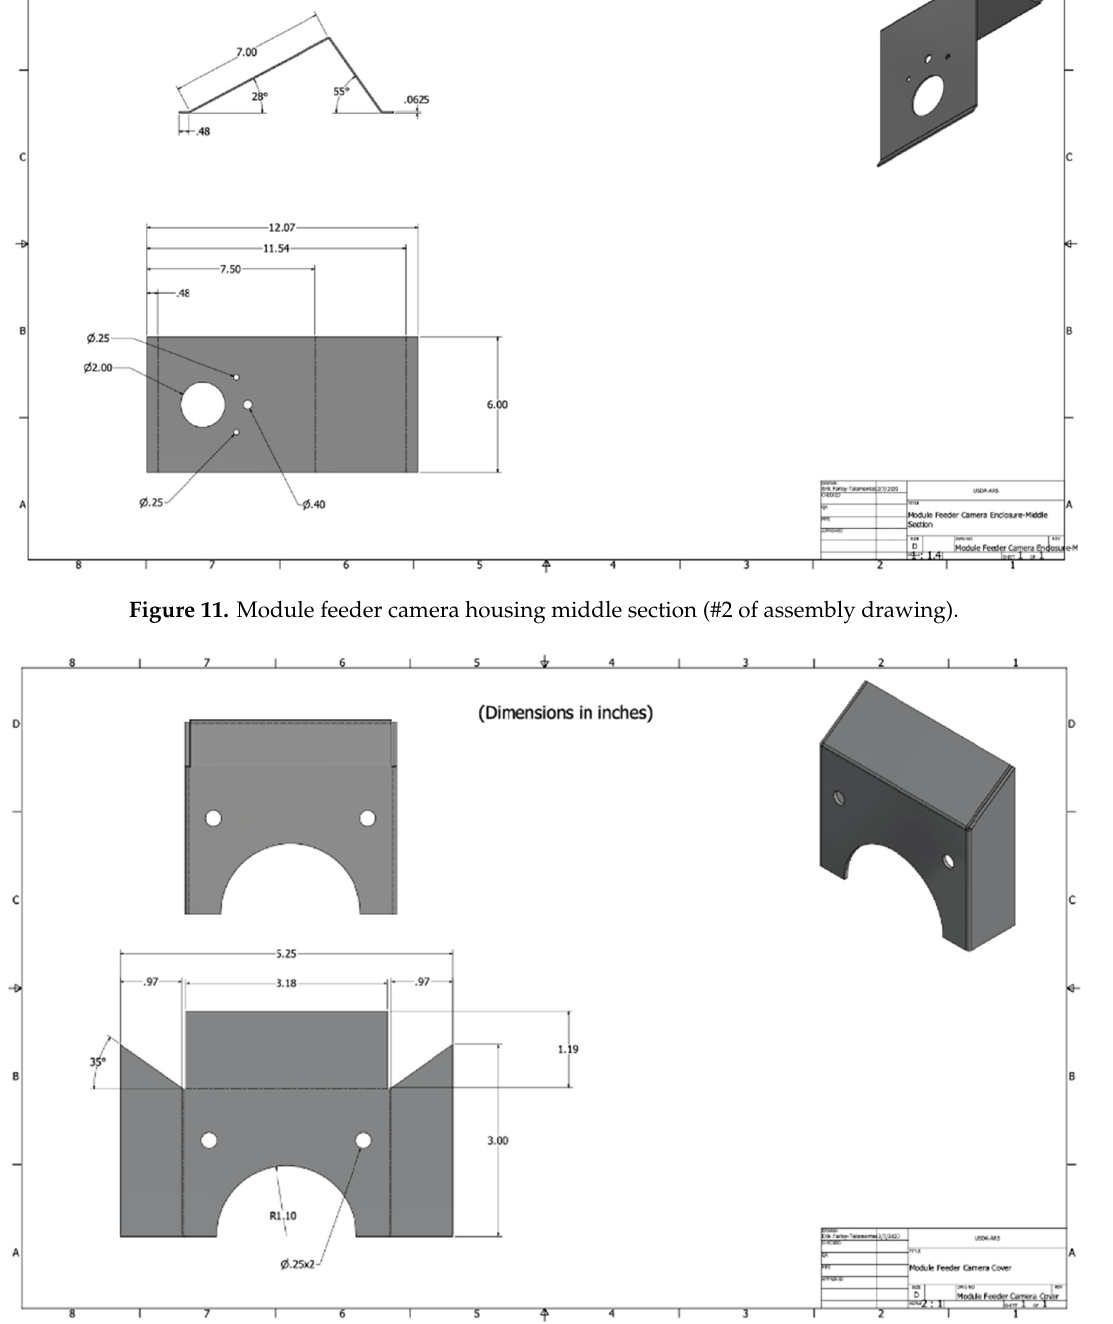
Figure 12. Module feeder camera housing air-wash tube protection cover (#4 of assembly drawing).